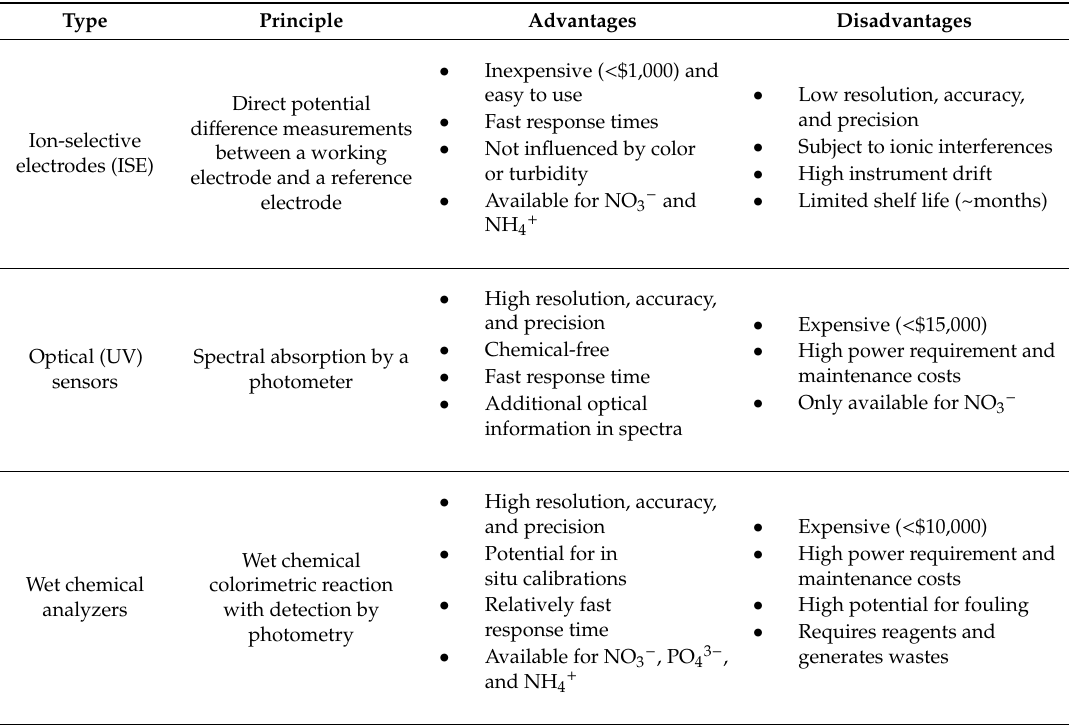
Table 2. Advantages and disadvantages of commercially available nutrient sensor technology